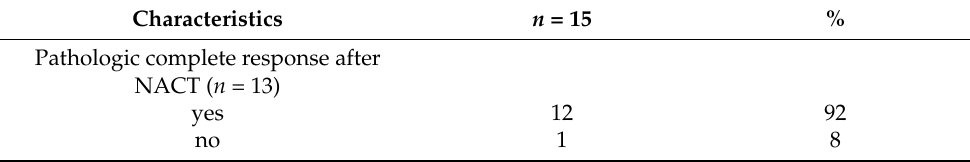
Table 1. Cont. Characteristics n = 15 % Pathologic complete response after NACT ( n = 13) yes